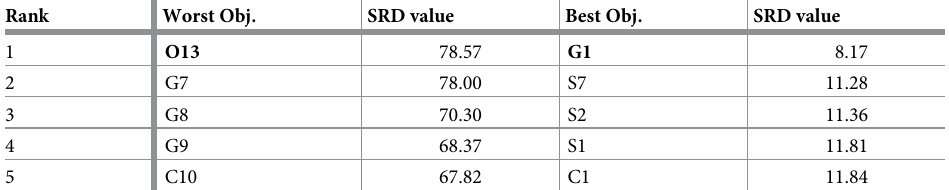
Table 1. SRD without preprocessing. The worst objectives, in terms of positive ranking, are proportional indicators: short-distance collaborations (C10); male (G7) and female (G8) authorships in proportion to the total number of authorships and female authorships (G9) in proportion to the authors who disclosed their gender. Rank Worst Obj. SRD value Best